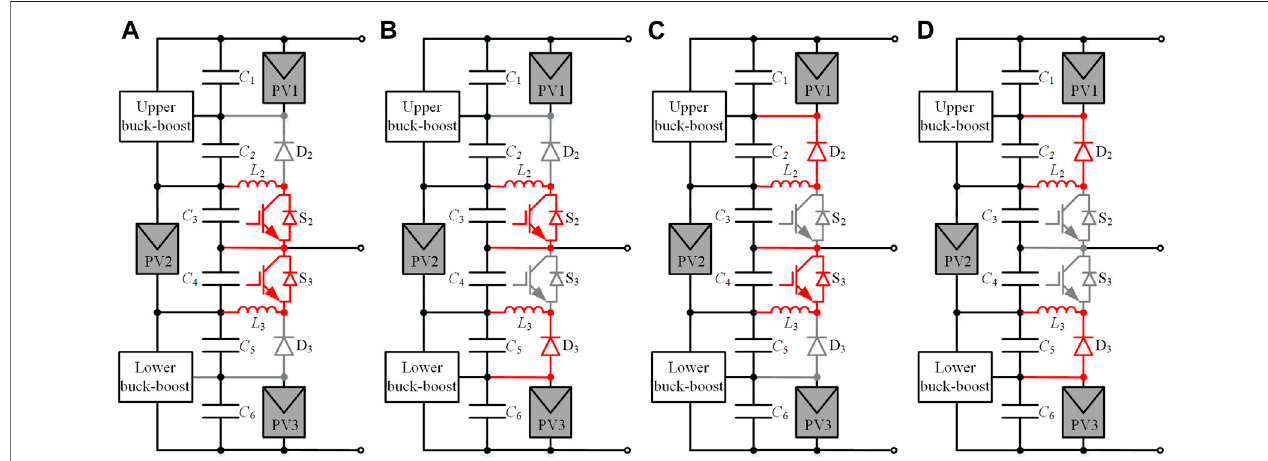
FIGURE 4 | (A) State 1, (B) state 2, (C) state 3, and (D) state 4 of the proposed converter.